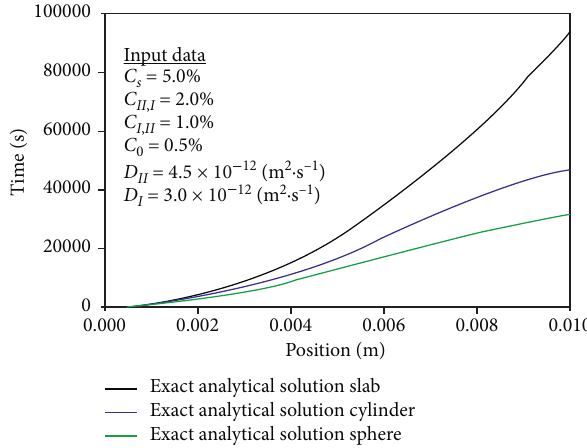
Figure 14: Comparison of similarity variables in relation to the concentration profiles during inward diffusion of a slab, a cylinder, and a sphere at 70% of R . 0